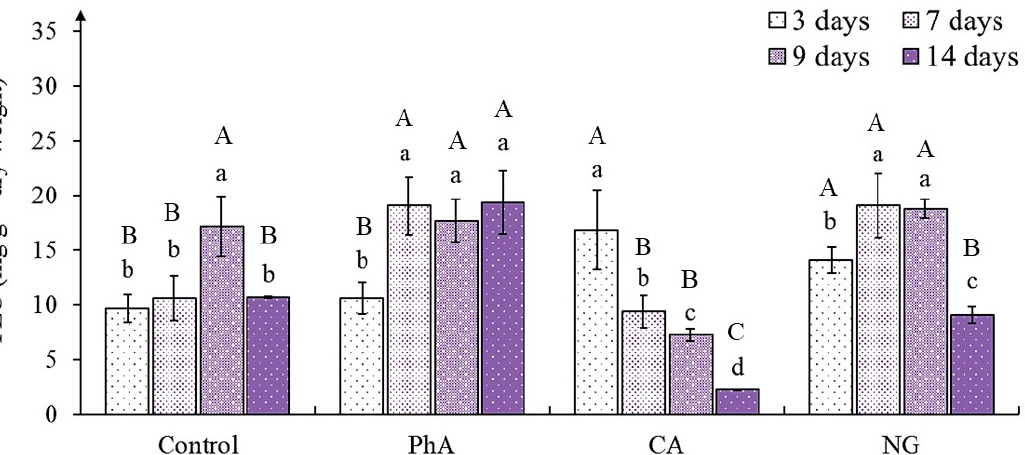
Figure 4. The flavans content (FLC) in tea callus cultures of various ages grown on liquid Heller culture medium of the basic composition (Control) or enriched with L -phenylalanine (PhA; 3 mM), trans -cinnamic acid (CA; 1 mM) or naringenin (NG; 0.5 mM). Results are expressed as means ± SDs, n = 3. The significant differences at p < 0.05 are denoted by different Latin letters: Uppercase letters indicate significant differences between precursor treatments in alphabetic order from highest to lowest, lowercase letters indicate significant differences between duration of precursor treatments in alphabetic order from highest to lowest. Pairwise multiple comparisons were carried out using Tukey’s range